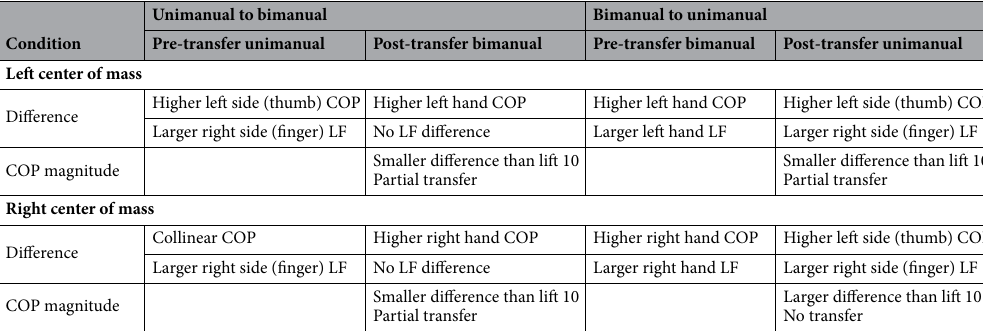
Table 2. Characteristics of torque generation before and after transfer. Details of the characteristics of center of pressure (COP) and load force (LF) difference in the pre- and post-transfer lifts. The 4 context switch conditions of the study are shown: (1) adding effectors (unimanual to bimanual) for an object with a left center of mass, (2) adding effectors (unimanual to bimanual) for an object with a right center of mass, (3) removing effectors (bimanual to unimanual) for an object with a left center of mass, (4) removing effectors (bimanual to unimanual) for an object with a right center of